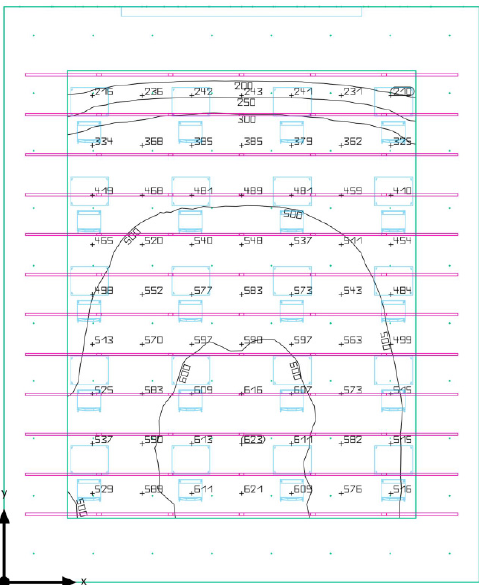
Figure 14. Illuminance distribution of the classroom by asymmetric distribution LED light tube.